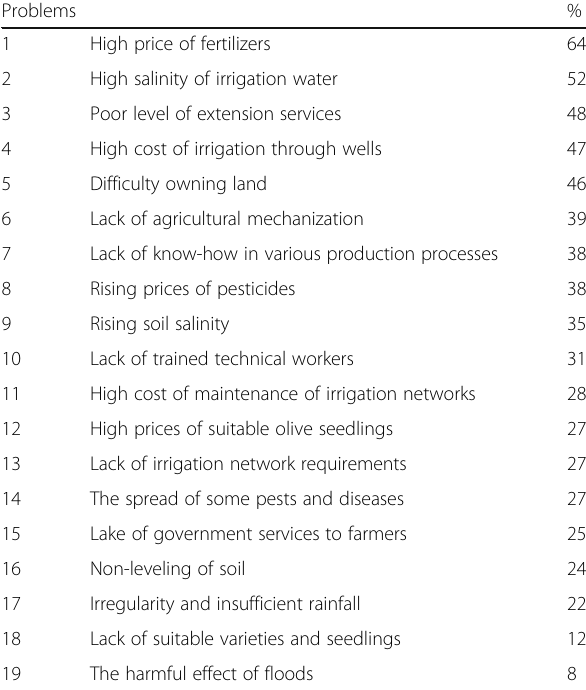
Table 3 Production problems facing olive farmers Problems